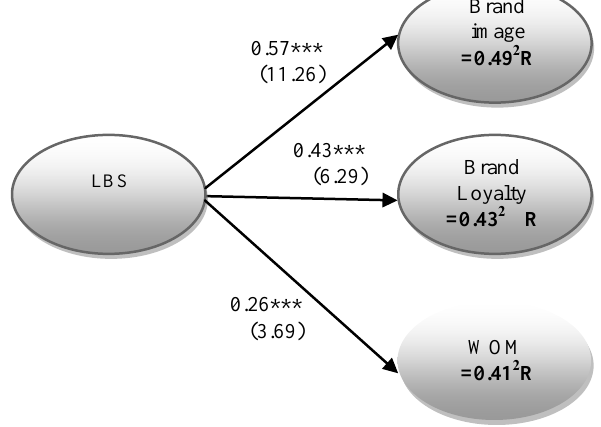
Fig 3. Results of path